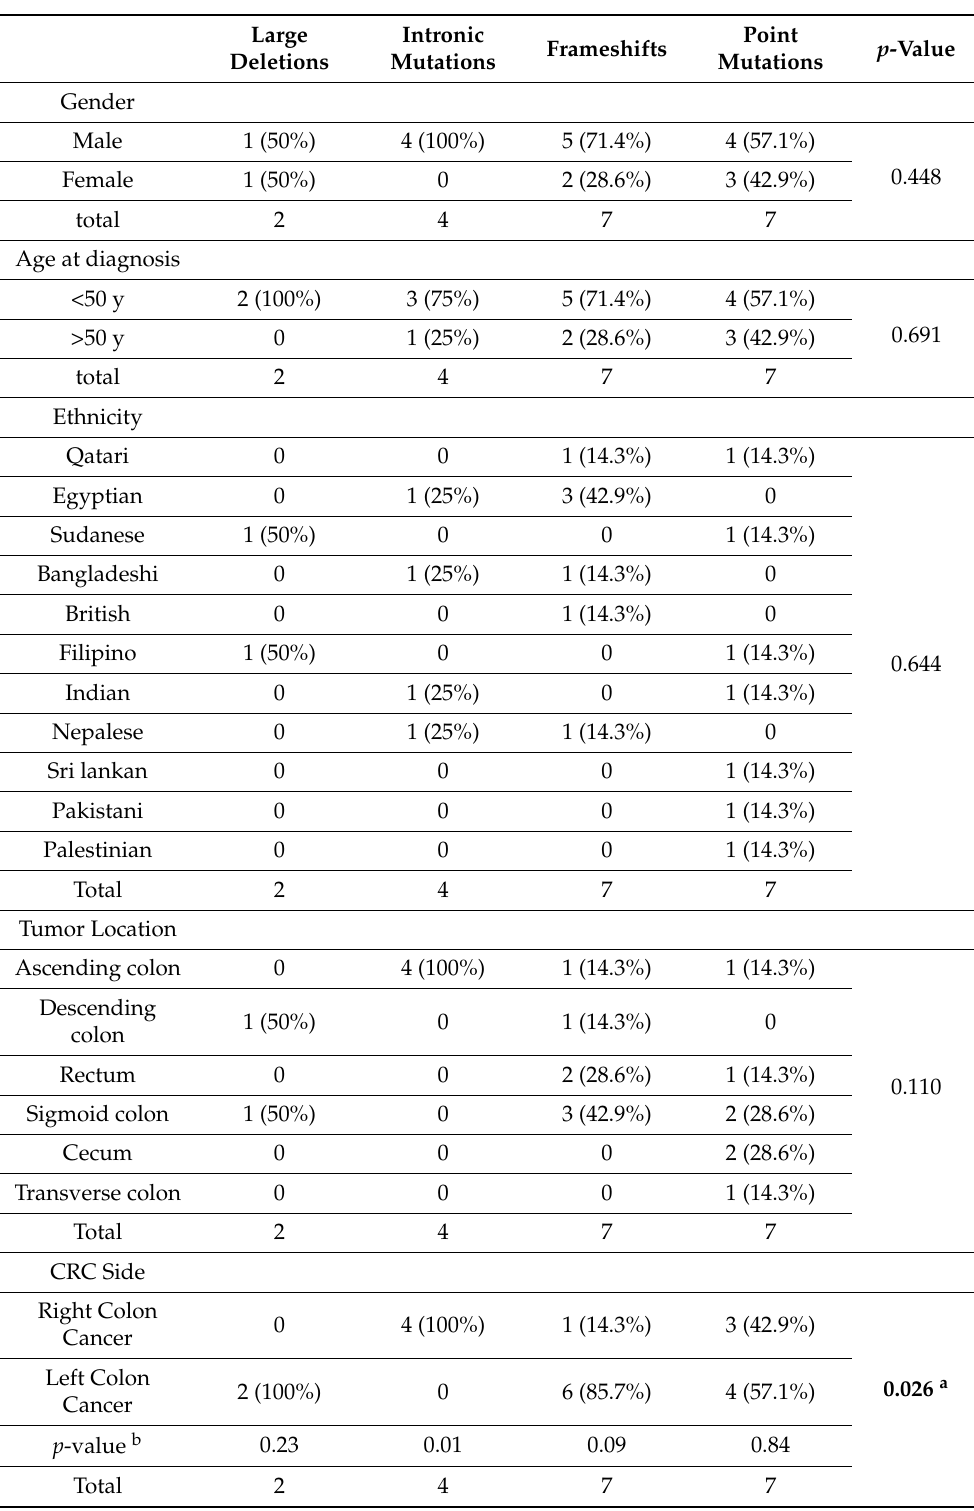
Table 6. Genotype- phenotype correlation with the type of the variant, LV: Lympho-vascular invasion, Invasive: Invasive cancer based on pathology. Large Intronic Deletions Mutations